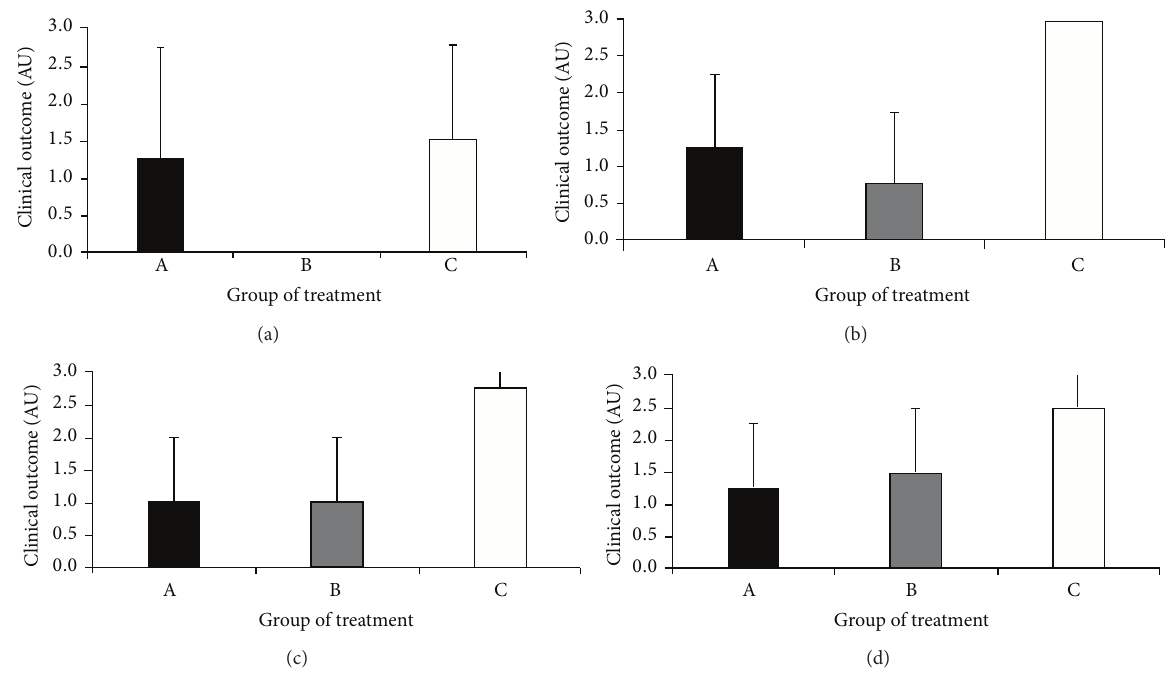
Figure 2: Clinical outcome after treatment with topical 5,3 󸀠 -hydroxy-7,4 󸀠 -dimethoxyflavanone isolated from P. gracilis Tul. fruit. Barsrepresent the mean value ± SD of clinical outcome in arbitrary units scored at the end of the treatment (a), PTD30 (b), PTD60 (c), and PTD90 (d). Axis 𝑥 : group treated with flavanone solution (group A); group treated with 2% flavanone cream (group B); and group treated with trademark meglumine antimoniate (group C). Axis 𝑦 : score of 0 = failure; 1 = relapse; 2 = clinical improvement; and 3 =